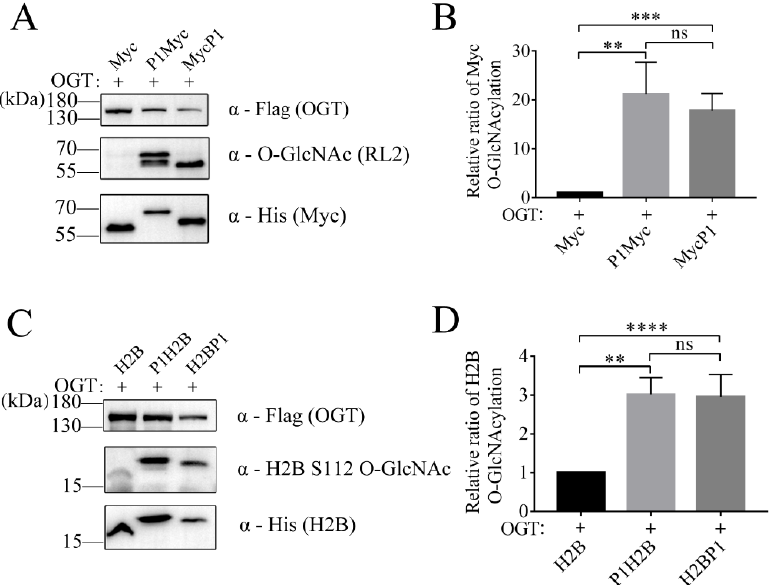
Figure 4. Targeting other proteins for O-GlcNAcylation with OBP-tagged strategy. ( A ) The expression and O-GlcNAc levels of Myc and ( C ) H2B were analyzed with a Western blot with anti-His, anti-Flag, and anti-O-GlcNAc antibody. The relative ratio of ( B ) Myc and ( D ) H2B O-GlcNAcylation was normalized and is presented as mean ± S.D. ( n = 3 biologic replicates). Statistical analyses were performed using Student’s t test, ****, p < 0.0001. ***, p < 0.001. **, p < 0.01. ns, p > 0.05.